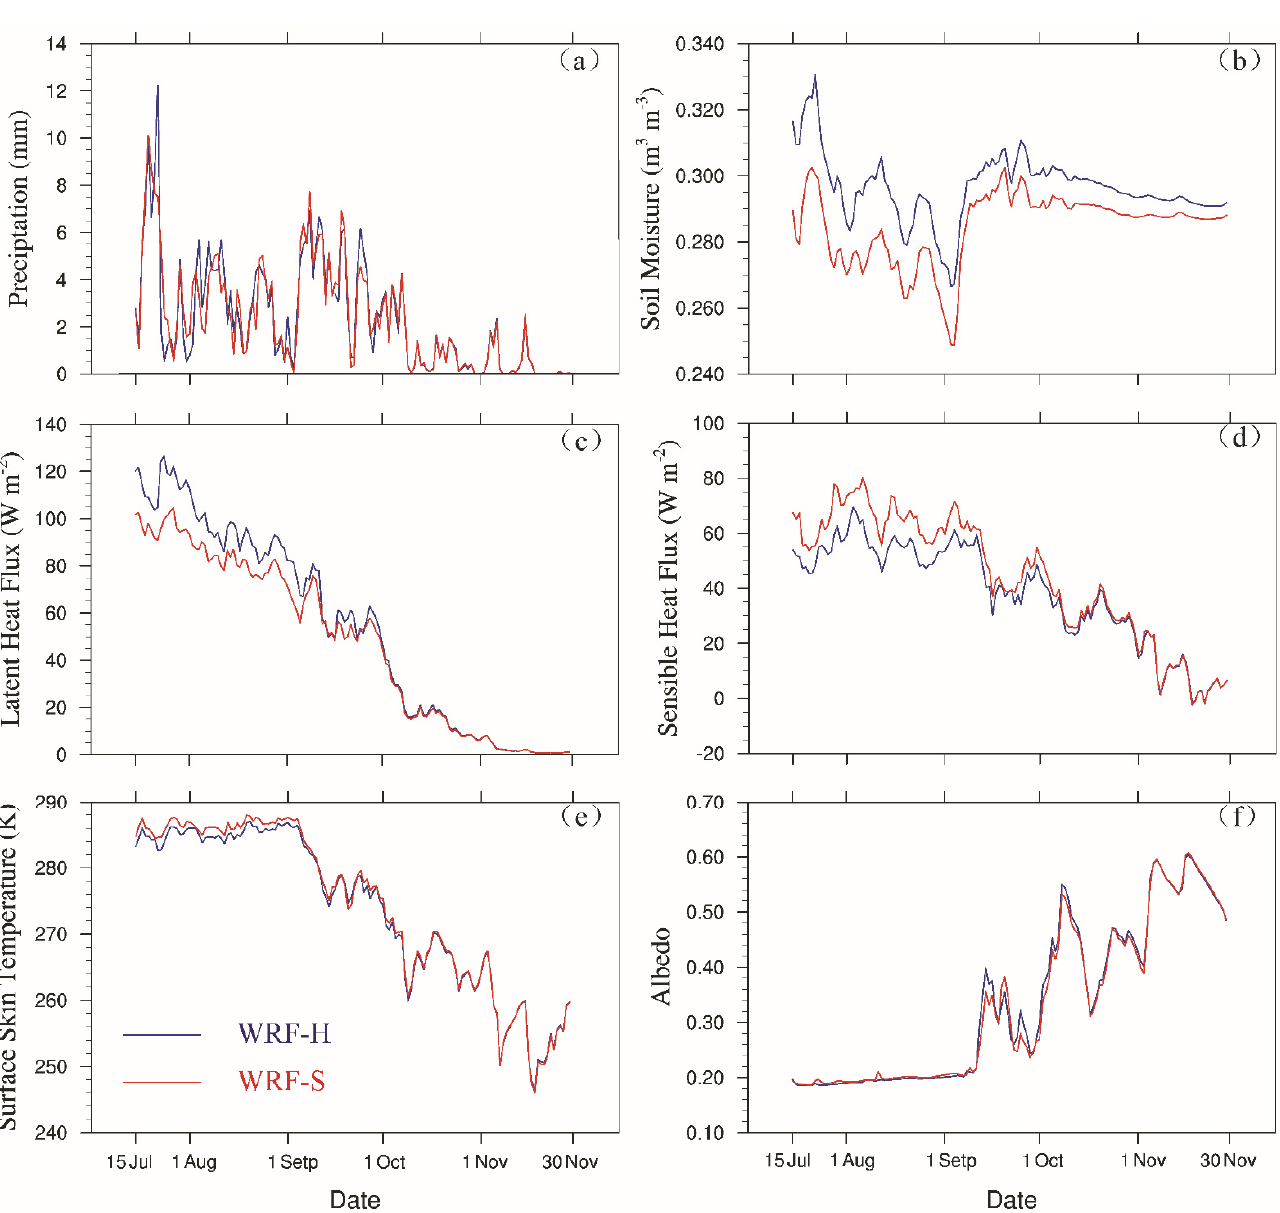
Figure 8. Temporal variations of the SRTR basin average in ( a ) precipitation, ( b ) soil moisture in the first soil layer (0~10 cm), ( c ) latent heat flux, ( d ) sensible heat flux, ( e ) surface skin temperature, ( f ) albedo.